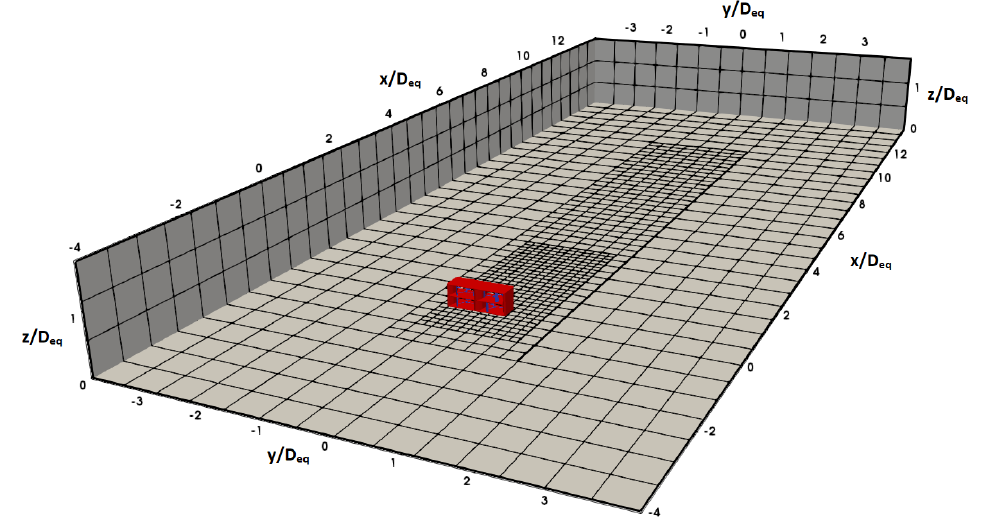
Figure 16. Illustration of the computational domain. Dimensions are scaled by the equivalent diameter D eq = 25.0 m. The mesh on the domain boundaries is represented in cubes of 14 × 14 × 14 nodes. Stator is in red and rotors are in